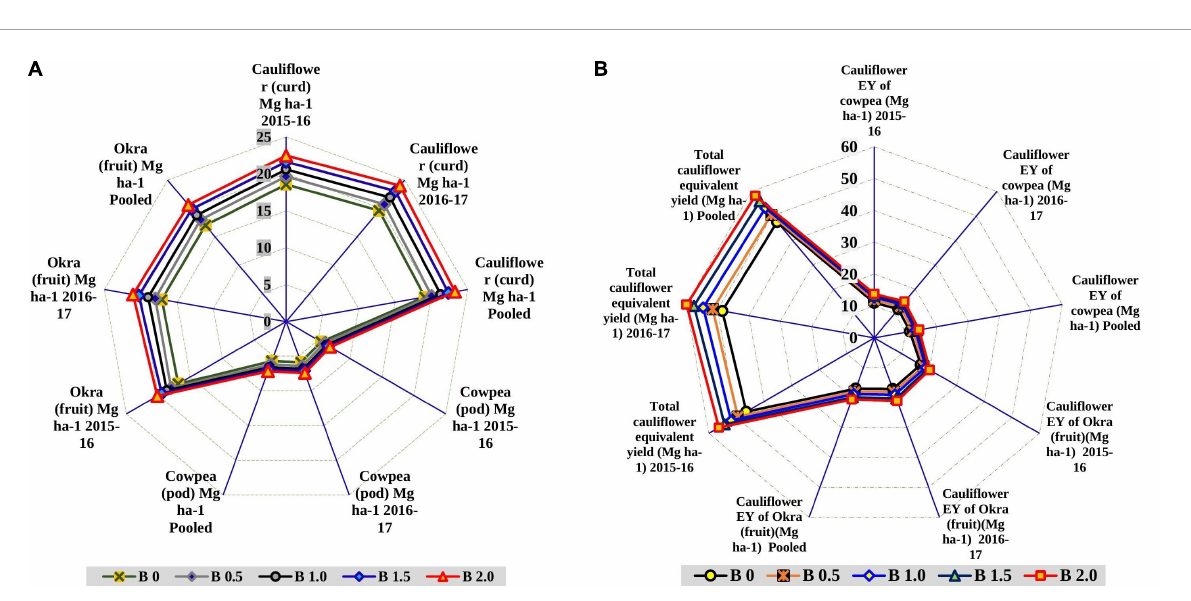
FIGURE2 Effect of graded B levels on crop yield (Mg ha − 1 ) in cauliflower-cowpea–okra cropping system (A) ; effect of graded B levels on CEY (Mg ha − 1 ) in cauliflower-cowpea–okra cropping system (B)